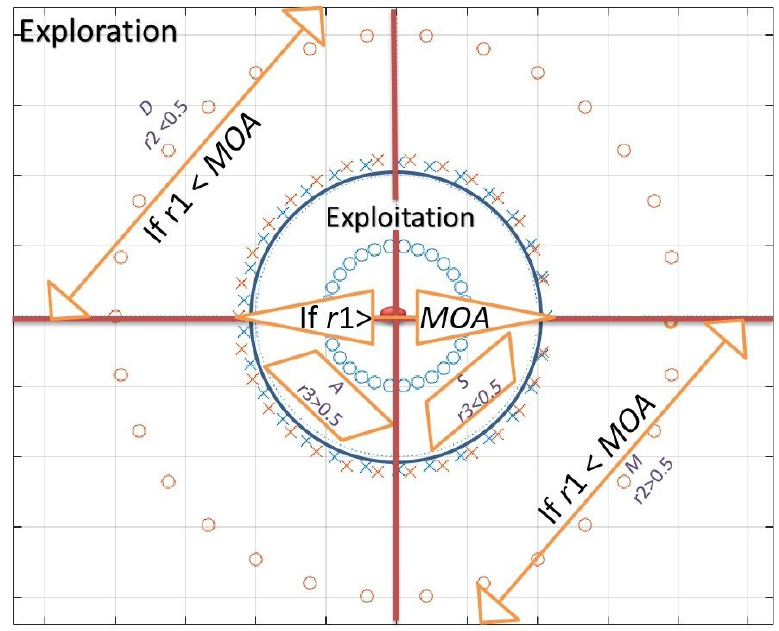
Figure 1. The search phases of the Arithmetic Optimization